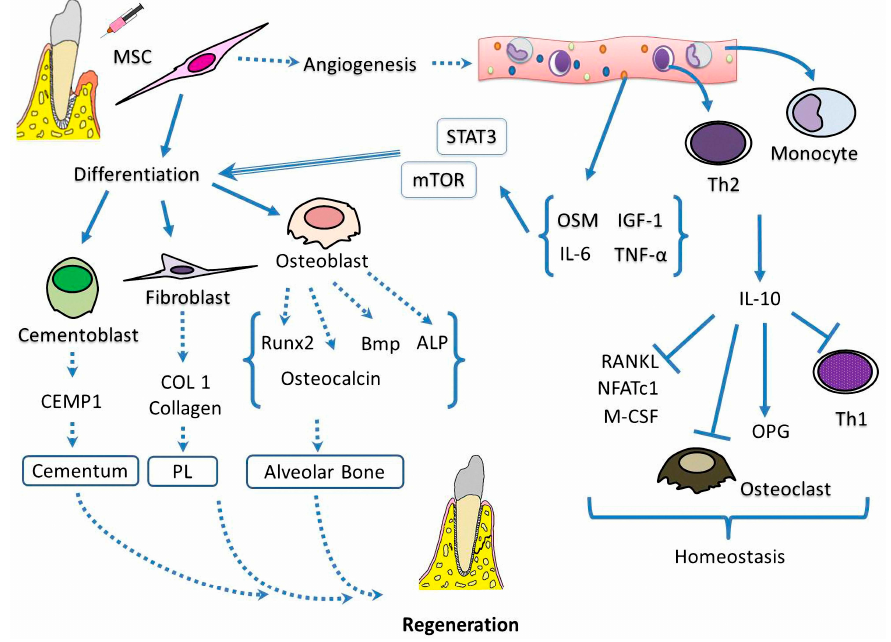
Figure 4. Putative mechanism involved in the regeneration of periodontal tissue via DP-MSCs. The placement of DP-MSCs allows the neoformation of blood vessels that carry signals (IL-6, IGF-1, and TNF- α andoncostatin M: OSM) and cells (Th2 and monocytes) to the site of the lesion. Signals, via the STAT3 and mTOR pathways, will allow the DP-MSCs to be transformed into osteoblasts, which in turn will produce ligands to bone morphogenic protein 2 (BMP), alkaline phosphatase (ALP), and runt-related transcription factor 2 (Runx2) for the generation of alveolar bone, whereas the production of IL-10 and osteoprotegerin (OPG) will create a suitable microenvironment in which osteoclast